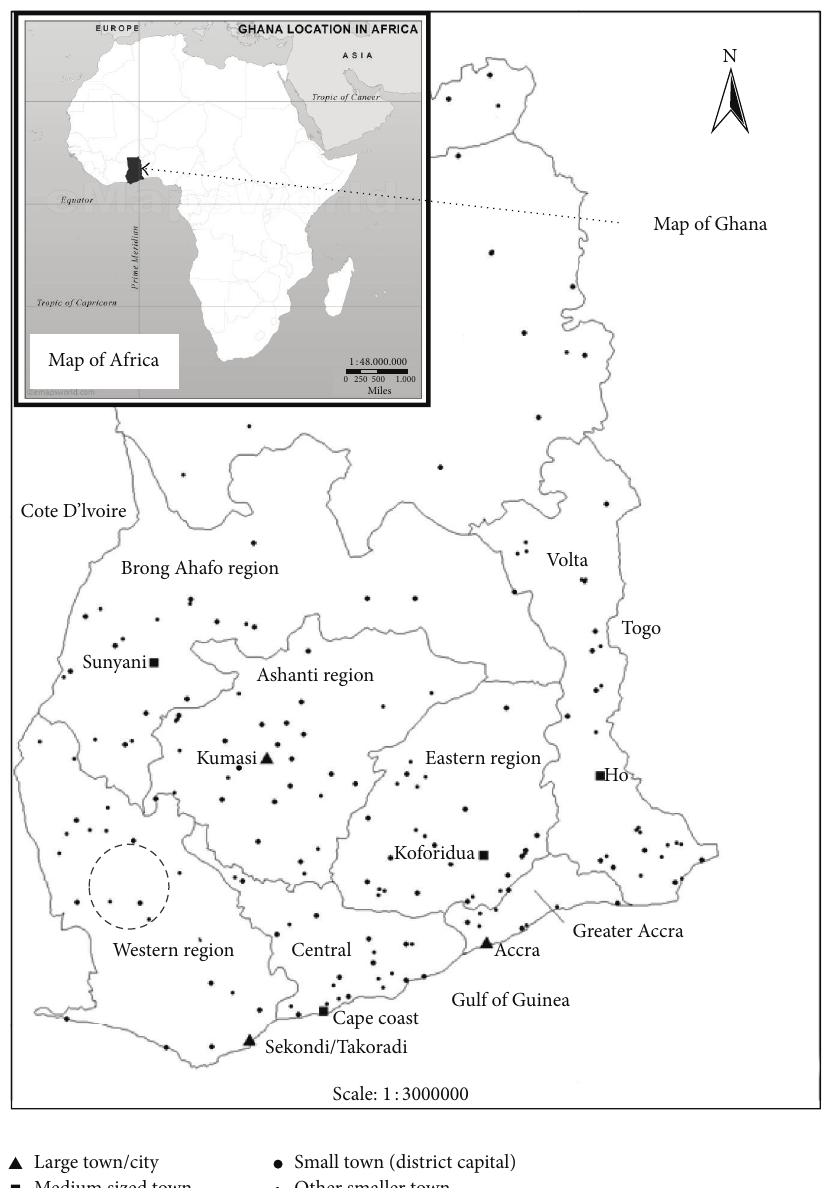
Figure 1: Location of the study area: Map of Africa (inset) and map of Ghana depicting the study area (marked with circle) within a humid tropical rainforest zone of